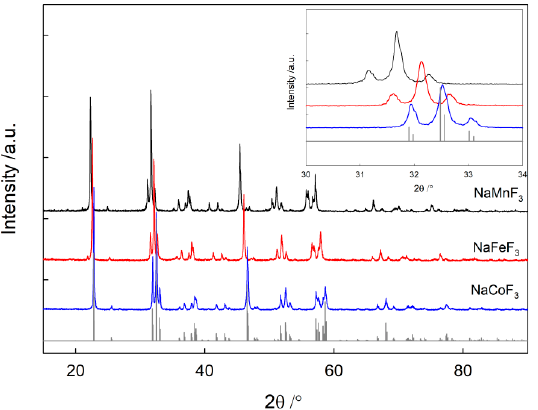
Figure 1. XRPD patterns of the NaMF 3 samples (M = Co, Fe, and Mn) prepared without sodium citrate. The vertical lines used for comparison (NaCoF 3 ) were calculated based on the data reported in [13] (ISCD 98-007-2321).